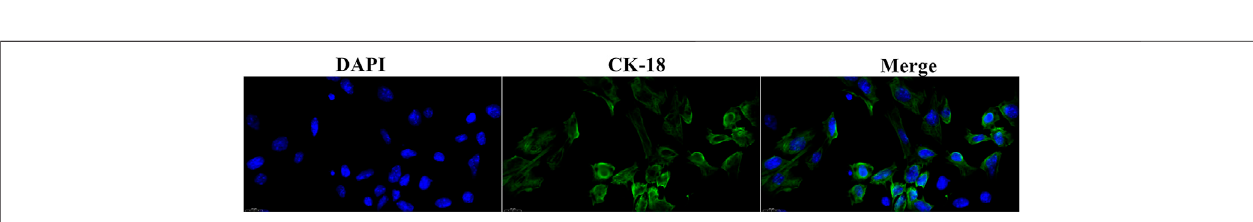
Frontiers in Pharmacology |